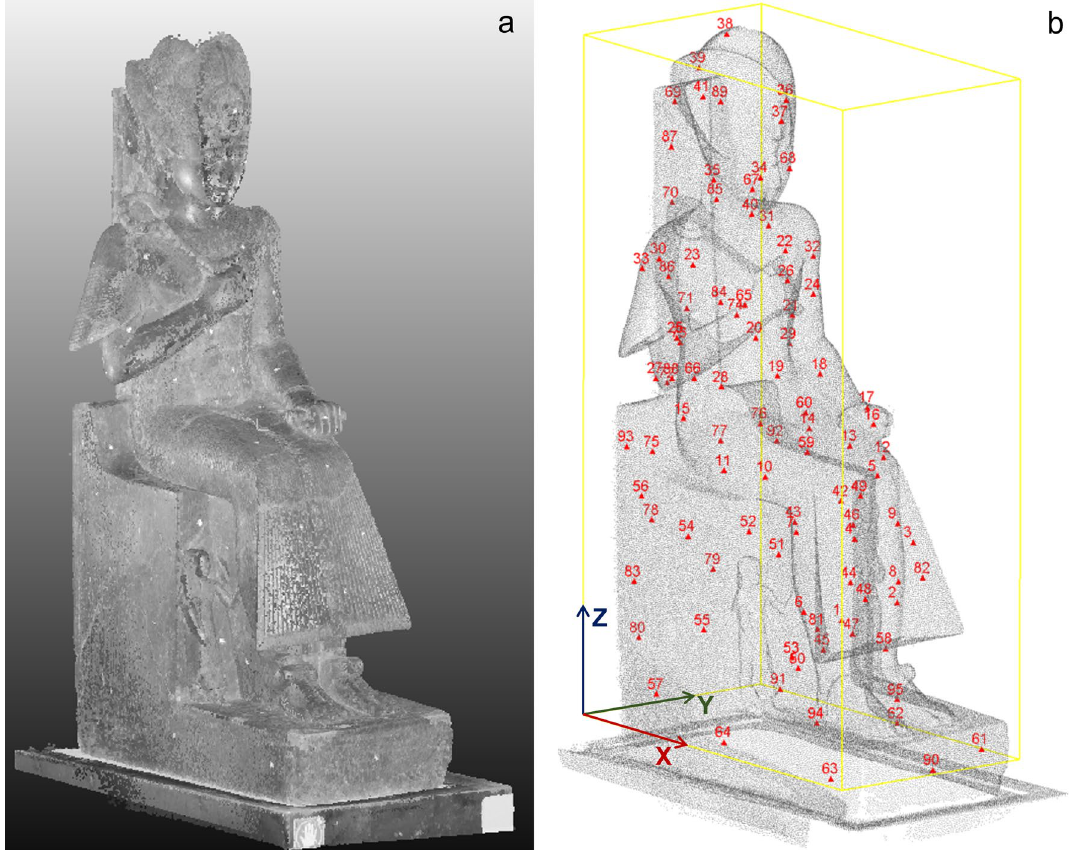
Figure 2. 3D model of the statue of Ramses II. ( a ) Point cloud with RGB colors obtained with ground-based laser scanning. ( b ) Complete point cloud obtained through handheld and ground-based laser scanning, with indication of the 3D ultrasonic tomography source and receiver locations (red triangles, georeferenced through total station measurements) and of the local reference system adopted in the study. Figure created in CloudCompare (version 2.12.2, https:// www. danie lgm. net/